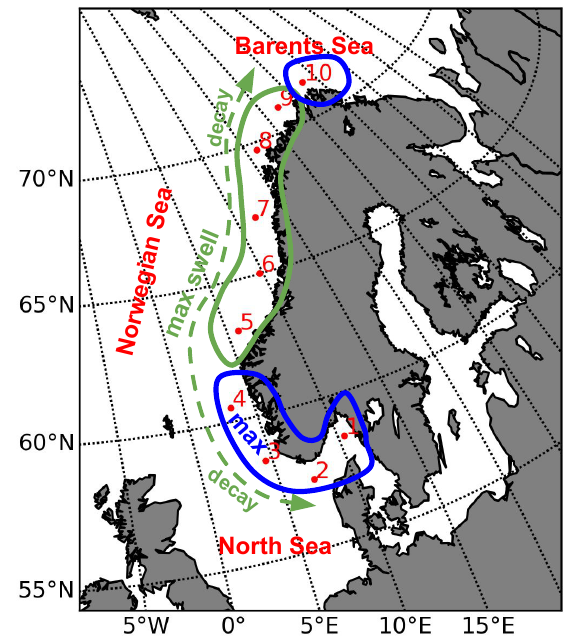
Figure 1. The 10 selected offshore points (red dots and numbers) along the Norwegian coastline. Areas dominated by wind sea ( WEF w > WEF s ) within blue-curve and areas dominated by swell ( WEF s > WEF w ) within green-curve. The dashed arrows show the direction of swell decay along the